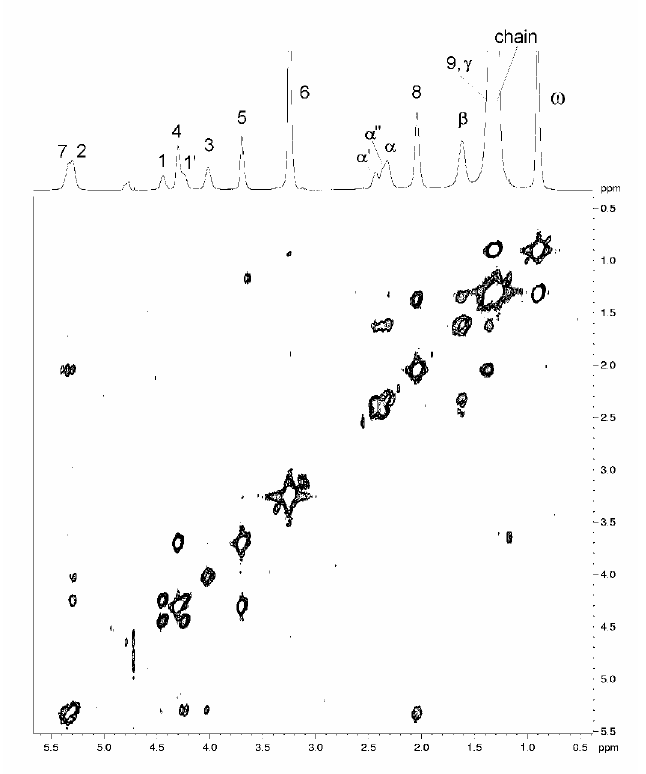
Figure 4. 1 H- 1 H COSY map of POPC MLVs obtained using a spinning rate of 6 kHz. The calibrated temperature value of 303.9 K was obtained setting the temperature at 300.0